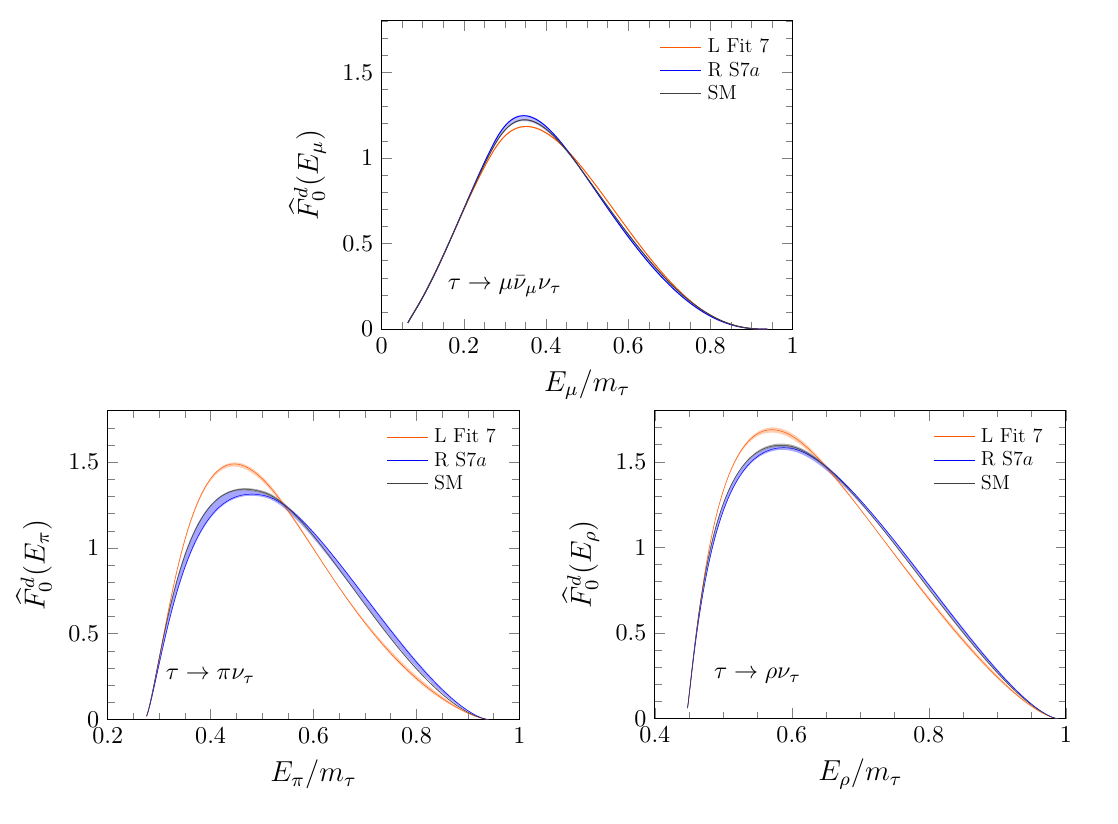
Figure 6 . Predictions for the b F d ( E d ) energy distribution [eq. (4.9)] for the Λ b → 0 Λ c τ ( µ ¯ ν µ ν τ , πν τ , ρν τ )¯ ν τ decays, keeping y = m d /m τ finite, obtained within the SM and the NP scenarios corresponding to Fit 7 of ref. [42] and Fit 7a of ref.